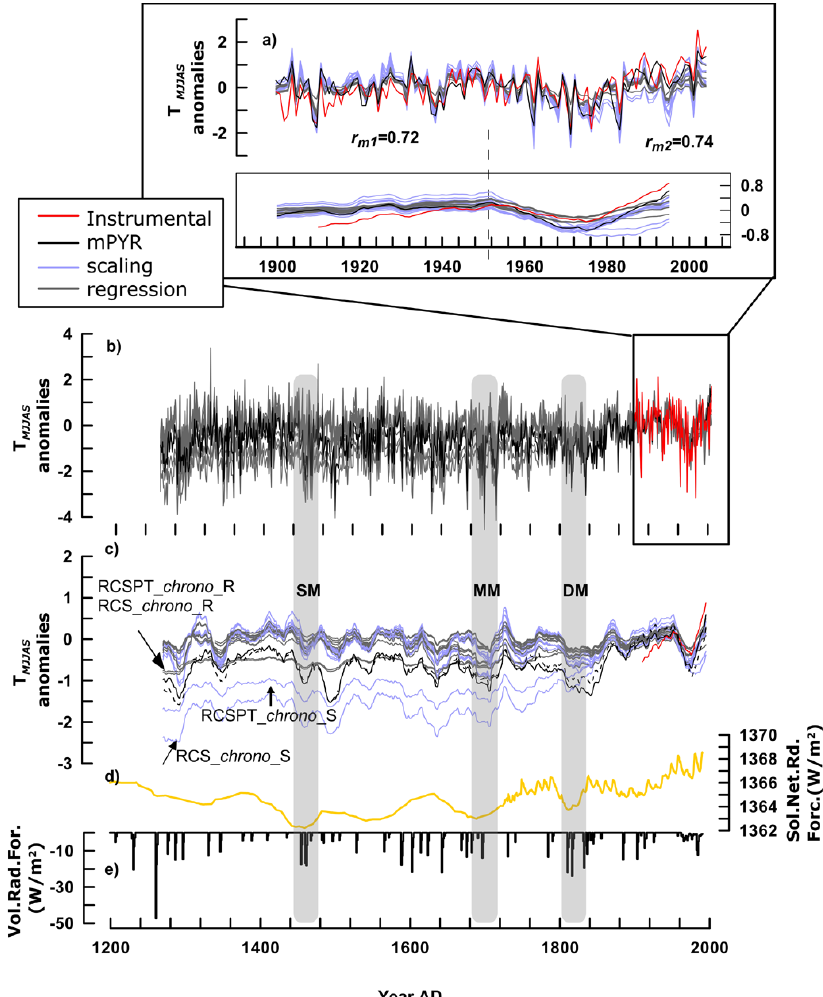
Fig. 6. May-to-September mean temperature ( T MJJAS ) reconstructions. (a) Calibration-verification for the 24 different regional reconstruc- tions performed by regression (grey lines) and scaling (blue lines), the mPYR (black line) and the instrumental T MJJAS record (red line). The bottom panel displays low-pass filtered series (20yr moving average). Mean correlations ( r m ) for the two split periods (1900–1952 and 1953–2005AD) are also shown; (b) comparison between the instrumental series, the 24 Pyrenees regional reconstructions and mPYR for the entire reliable period; (c) 20yr low-pass filtered reconstructions and instrumental record. The dashed black line represents the original May-to-September maximum temperature reconstruction from B ¨ untgen et al. (2008) (PYR); (d–e) solar and volcanic forcing derived from Crowley (2000) and used to drive the climate models. Shaded areas indicate periods with solar grand minima: Dalton minimum (DM), Maunder minimum (MM) and Sp¨orer minimum